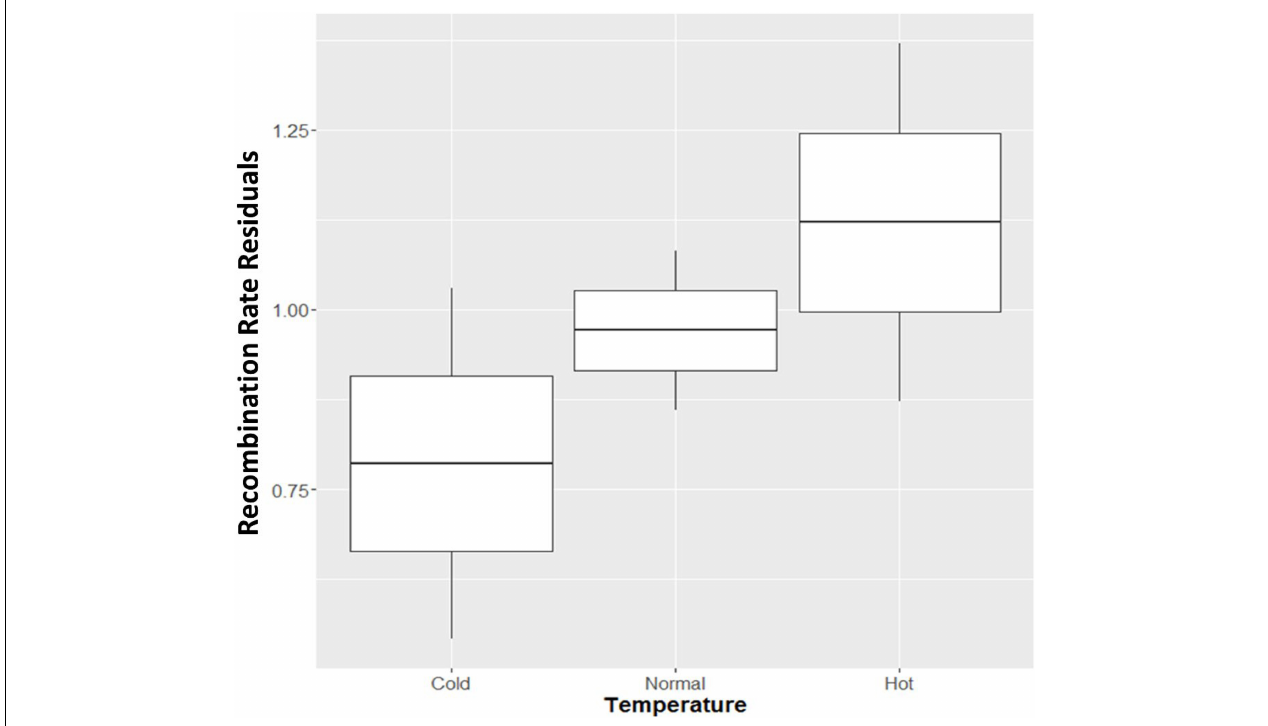
FIGURE 2 | Boxplot of recombination rate residuals in three temperature conditions during the fetal development of offspring. Cold: temperatures below 4.44 ◦ C; Normal: temperatures between 4.44 and 26.67 ◦ C; Hot: temperatures above 26.67 ◦ C.